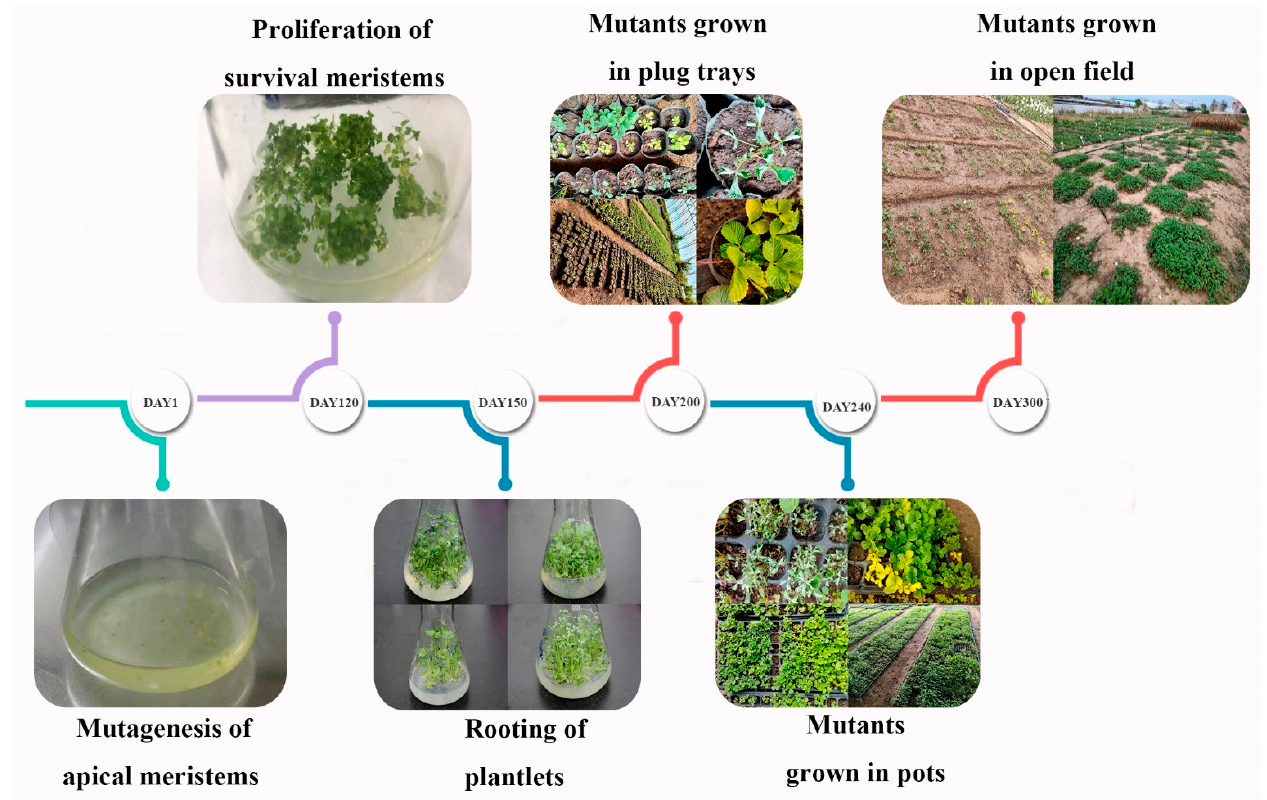
Figure 1. The establishment process of EMS mutant library in F. nilgerrensis . Table 2. Statistics on EMS mutant types and their ratios in F. nilgerrensis The 86 mutants were classified into 3 categories and 17 types according to the char- acteristics of plant, leaf, and flower (Supplementary Figure S1; Table 2). Among these mu- tants, plant posture mutants, including dwarf plants and clumped plants, accounted for 2.33% of total mutants. The leaf mutant was the most frequent mutant, with a mutation rate of 4.00%, including leaf color, leaf shape, leaflet number, and leaf size (Supplementary